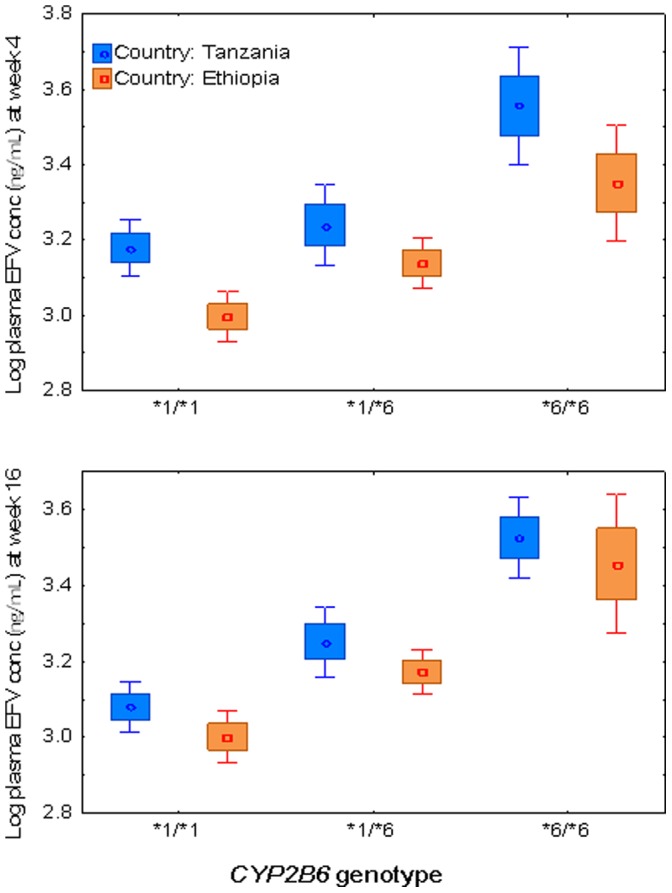
Comparison of mean log efavirenz plasma concentrations at week 4 and week 16 of efavirenz therapy between Ethiopian and Tanzanian HIV patients having the same CYP2B6*6 genotype.Boxes indicate mean ± SE of the mean; bars indicate mean ±1.96 × SE of the mean.